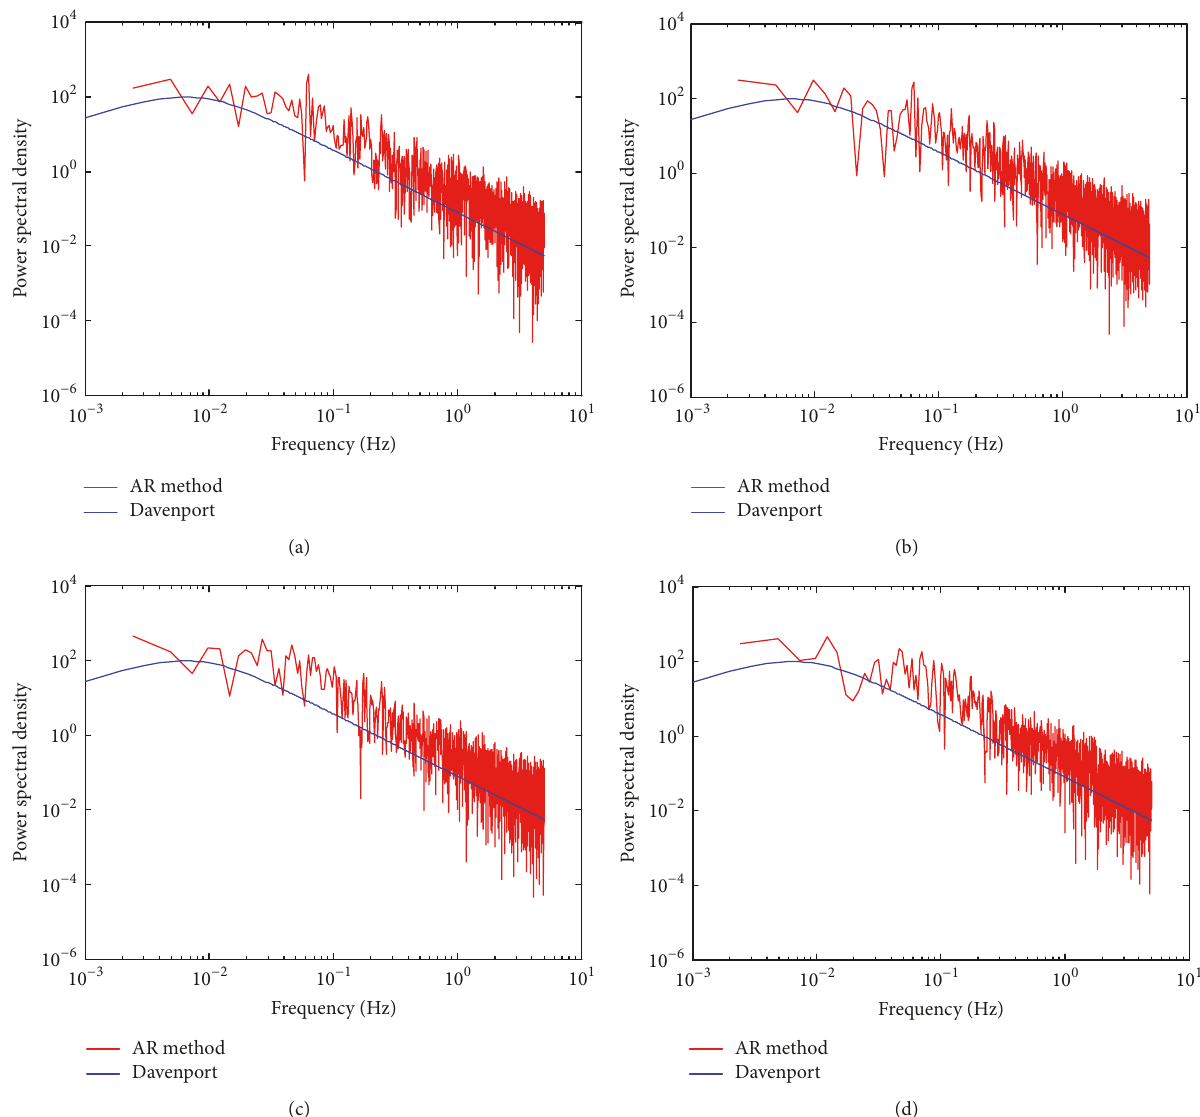
Figure 2: Comparison of power spectral density between simulated and Davenport spectra. (a) On the 5th floor; (b) on the 10th floor; (c) on the 15th floor; (d) on the 20th